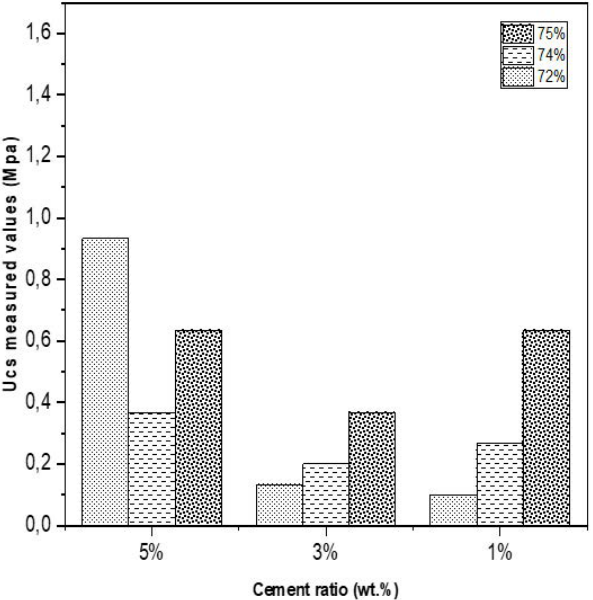
Figure 9. Effects of the solids content of CWTB mixtures prepared with 1 wt. %, 3 wt. % and 5 wt. % OPC binder on the variation in unconfined compressive strength with cement